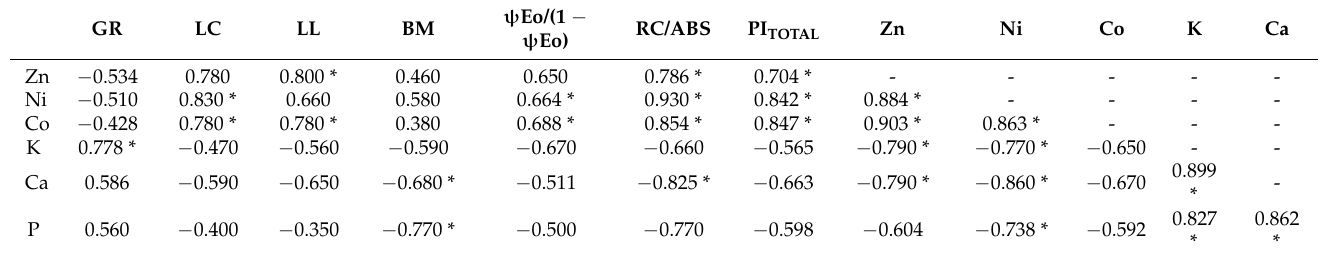
Figure 4. Chlorophyll a fluorescence transients (mean ± std) of B. radula leaves for the study treat- ments. Different lowercase letters indicate significant difference among treatment curves. * signifi- cantly different turnover steps among treatments (Tukey; p < 0.05). Table 3. Correlation coefficients among developmental parameters, photosynthetic efficiency and heavy metals and macronutrients in B. radula leaves, with significant relations among each other.